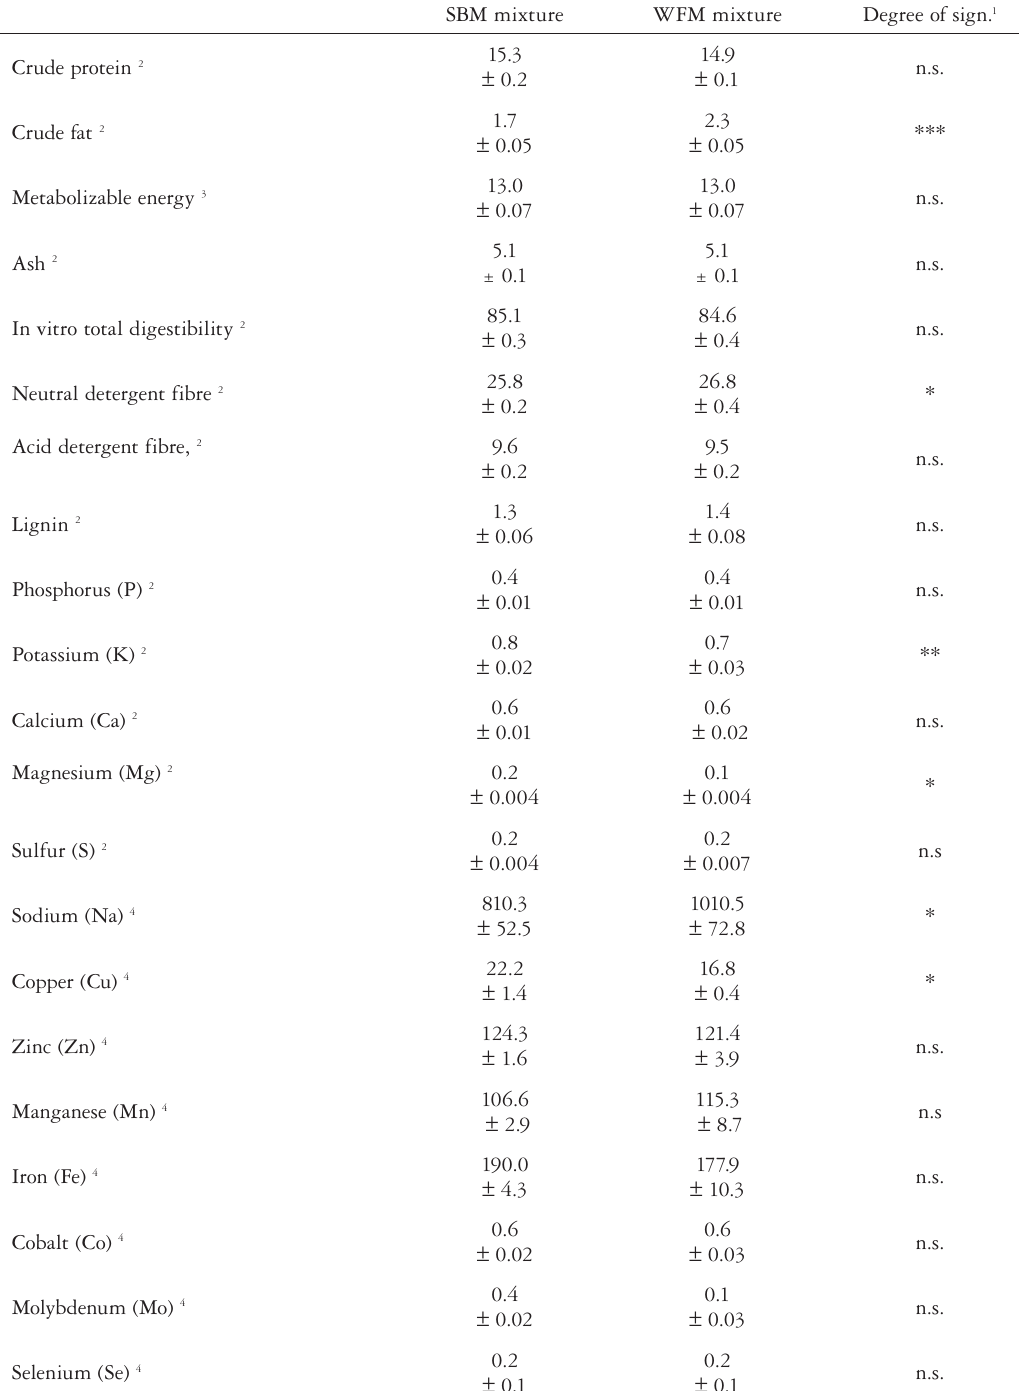
Table 1. Nutritional values on a dry matter (DM) basis (least-squares means ± standard errors) for the two feed mixtures used in the study; soybean meal mixture (SBM; n =10 samples) and fishmeal mixture (WFM; n =7